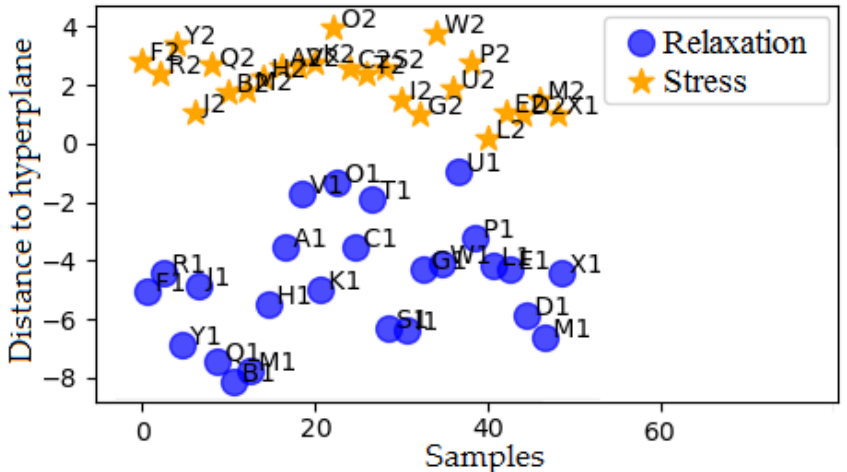
Figure 11. The graphical response of the Support Vector Machine (SVM) algorithm in the GSR